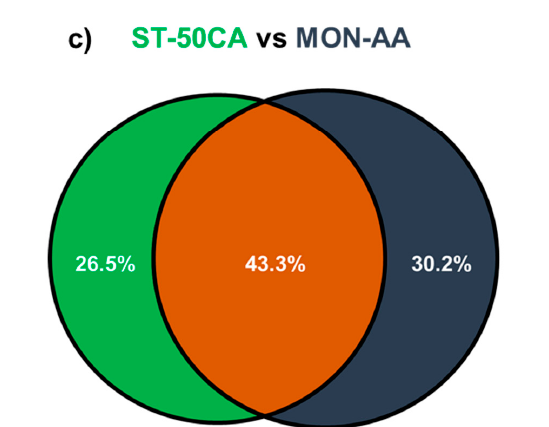
Figure 3. Selectivity differences based directly on the identified PPs. ( a ) Percentage of PPs identified without enrichment (Control) and the ST-50CA method; ( b ) Percentage of PPs identified without enrichment (Control) and the MON-AA method; ( c ) Percentage of identified PPs with the ST-50CA and the MON-AA methods. For each method, the results of 5 parallel experiments were